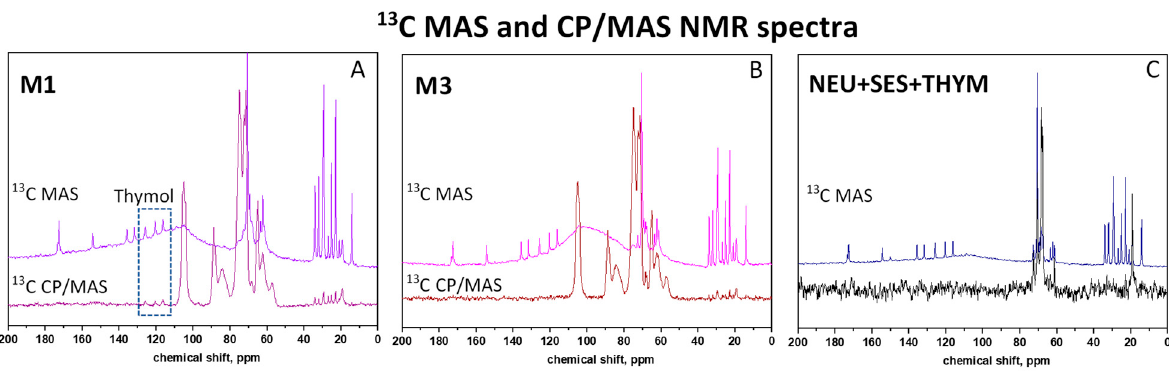
Figure 6. Detailed comparison of the 13 C CP/MAS and 13 C MAS NMR spectra of: ( A ) the pellet cores M1, ( B ) the pellet cores M3, ( C ) the model physical mixture Neusilin ® + SES + thymol.